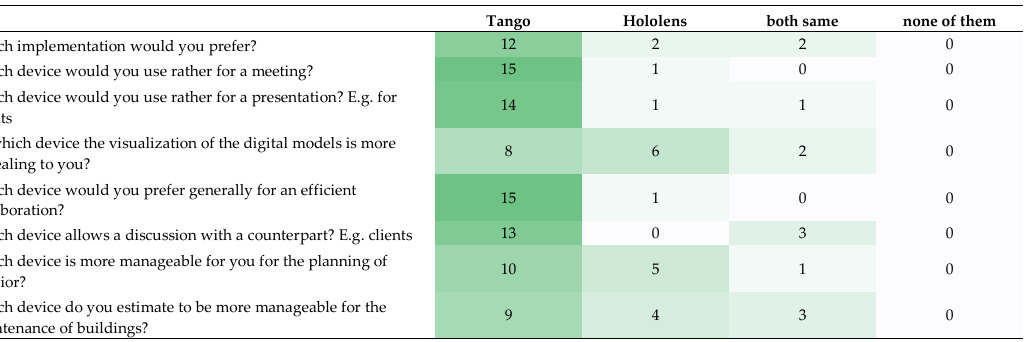
Table 3. Comparison between Tango and